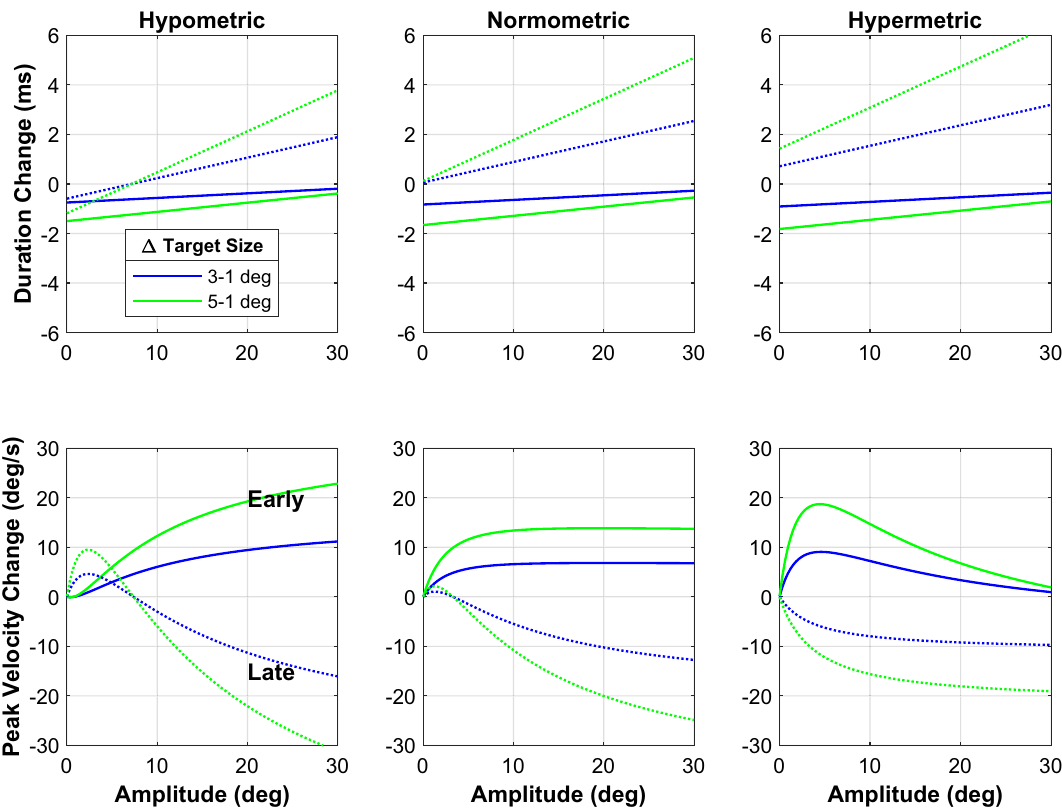
Figure 7. Main sequence differences between target sizes. Here we plot the change in duration and peak velocity between the target sizes. The blue lines show the difference between the 1° and the 3° target. The green lines show the difference between the 1° and the 5° target. Positive values indicate an increase in duration or peak velocity compared with saccades to the 1° wide